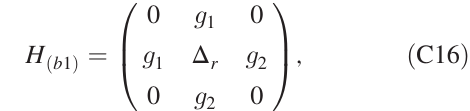
ω , DQD 1 ( 2 t 1 = 2 π ¼ 5 . 183 GHz) is brought in r ¼ DQD 2 ω g 1 ≈ ω (red arrows), ω r ¼ DQD 2 DQD 2 þ DQD 1